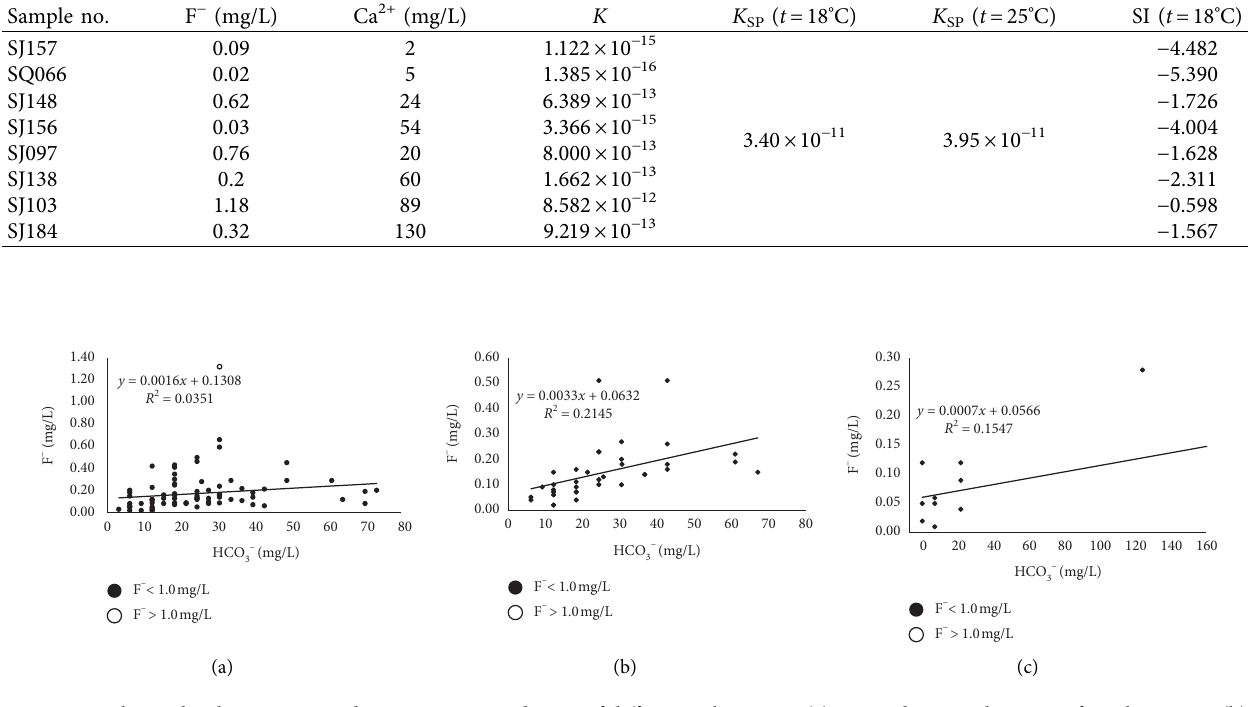
sp ), and SI of CaF 2 in groundwater.